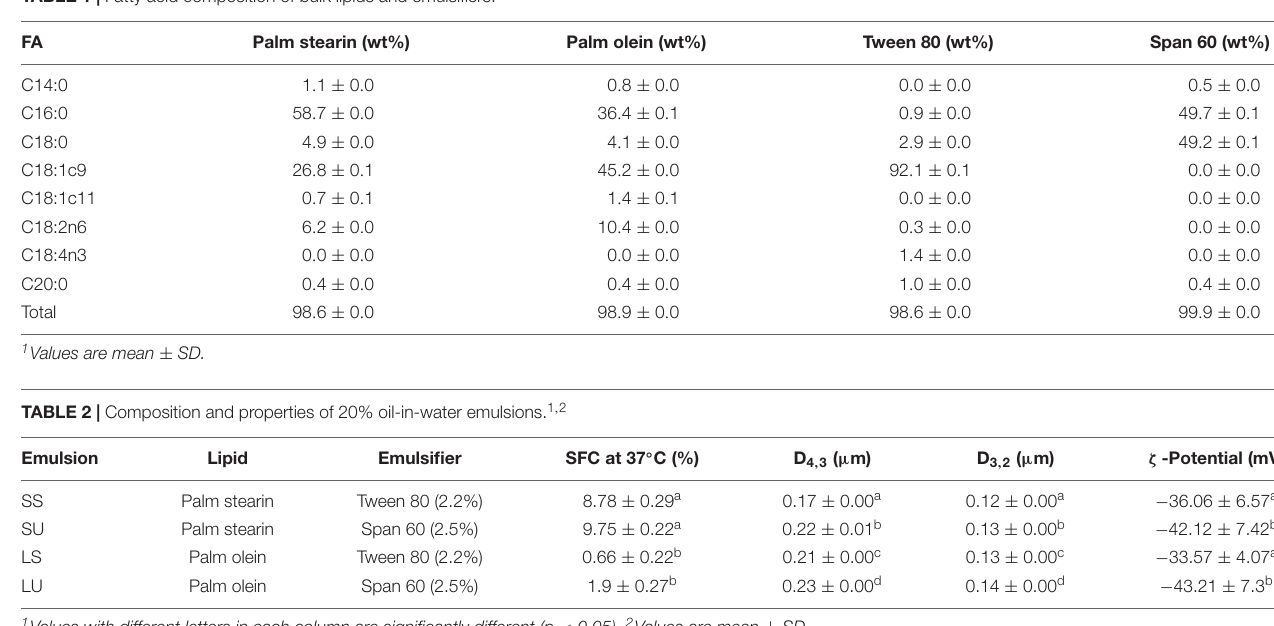
TABLE 1 | Fatty acid composition of bulk lipids and emulsifiers. 1